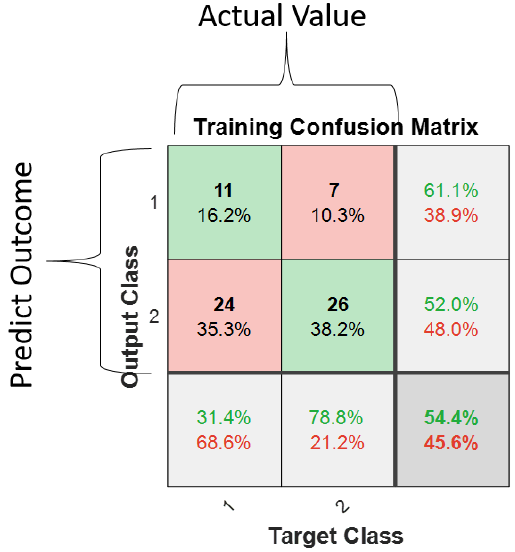
Figure 10. An example of confusion matrix.